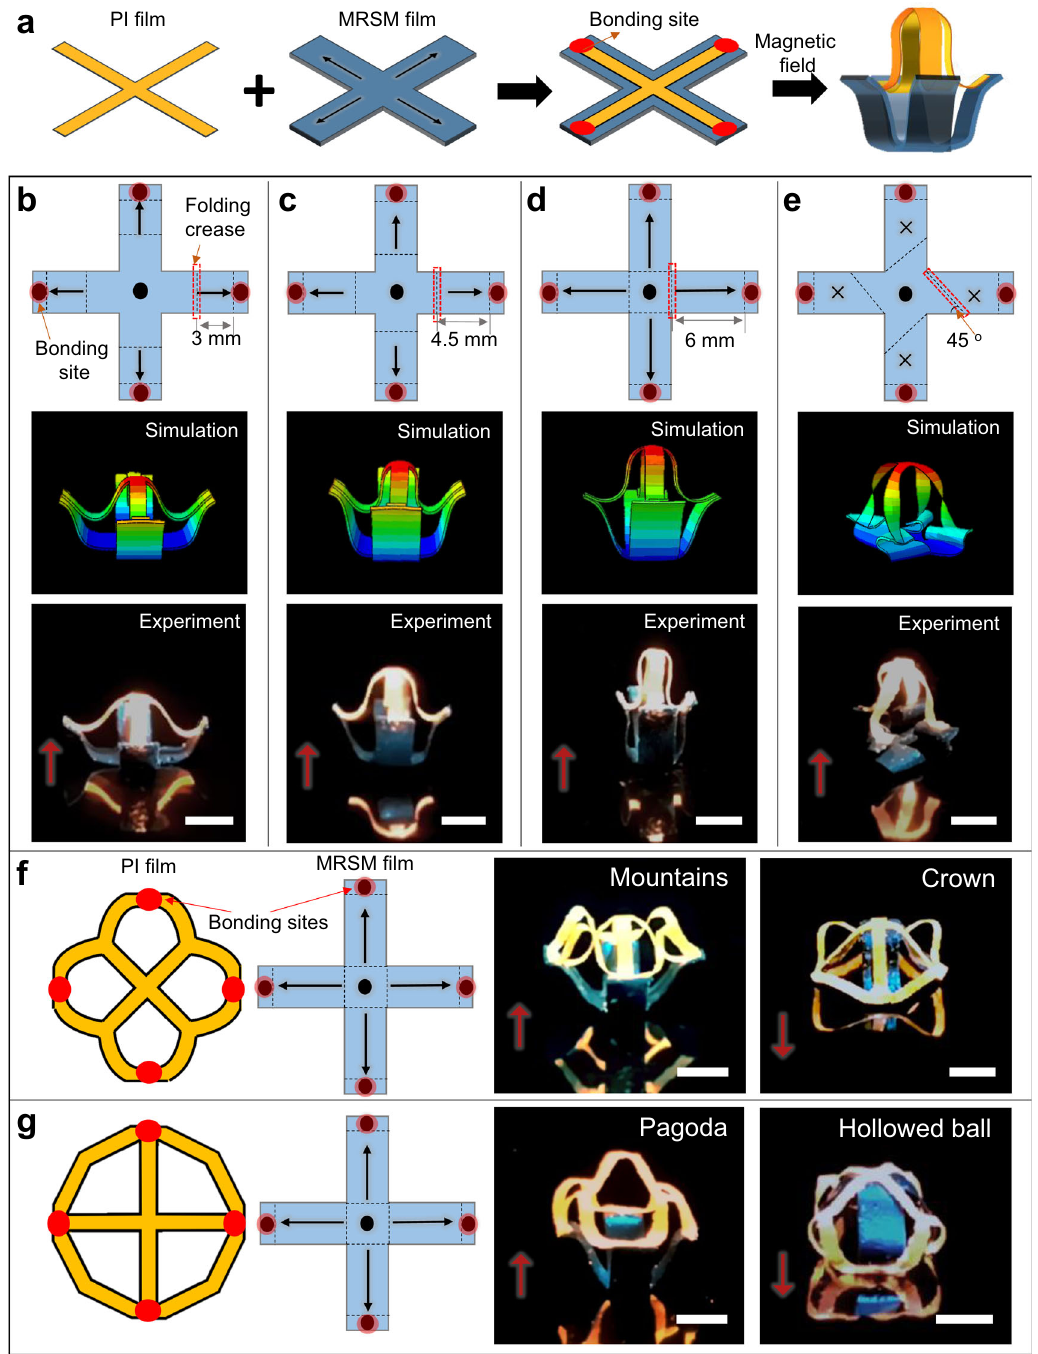
Fig. 4 Functional demonstration of MRSM substrates for responsive 3D structure assembly. a Schematic showing fabrication of a buckled 3D structure driven by a magnetically responsive MRSM substrate. b – e Schematic of four types of magnetization patterns in a MRSM substrate, FEA prediction, and optical images of buckled 3D structures with different buckling heights ( b – d ) and a twisted 3D structure ( e ). The polyimide (PI) fi lm was treated by fl uorescent dye to facilitate the observation. f , g Two representative PI patterns, schematic of magnetization patterns of a MRSM substrate, and optical images of buckled 3D structures. Red dots indicate the bonding sites between PI fi lms and MRSM substrates. Red arrows indicate the directions of the actuation magnetic fi eld of 150 mT. Scale Bars: 5 0.7 cm after ten cycles of motion. (Fig. 6a, Supplementary Fig. 15 quickly recovers to its fl at state when the magnetic fi eld fades as and Supplementary Movie 8). To mimic the crawling of an magnet passes the soft robot (Supplementary Fig. 16). By inchworm, which folds its body into an arch structure during the repeating the actuation process, the MRSM soft robot moves movement, an alternated magnetization pattern is encoded in the forward by cycling movement of arching and stretching just like a MRSM fi lm as shown in Fig. 6b. Upon the magnetic actuation, creeping inchworm, which moves 3.2 cm after ten cycles of the MRSM soft robot folds into an arch structure, and then motion. (Fig. 6b, Supplementary Fig. 17 and Supplementary